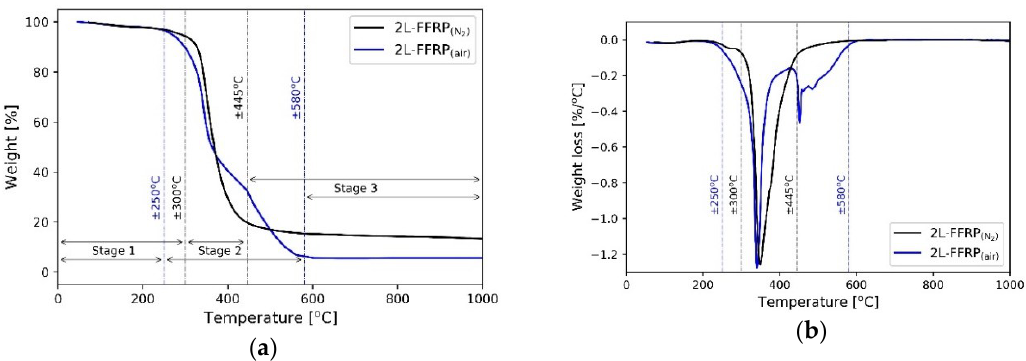
Figure 2. The thermal stability of 2L-FFRP composite tested in air and nitrogen atmosphere conditions: ( a ) thermogravimetric analysis (TGA) curves, ( b ) derivative thermogravimetric (DTG) curves.